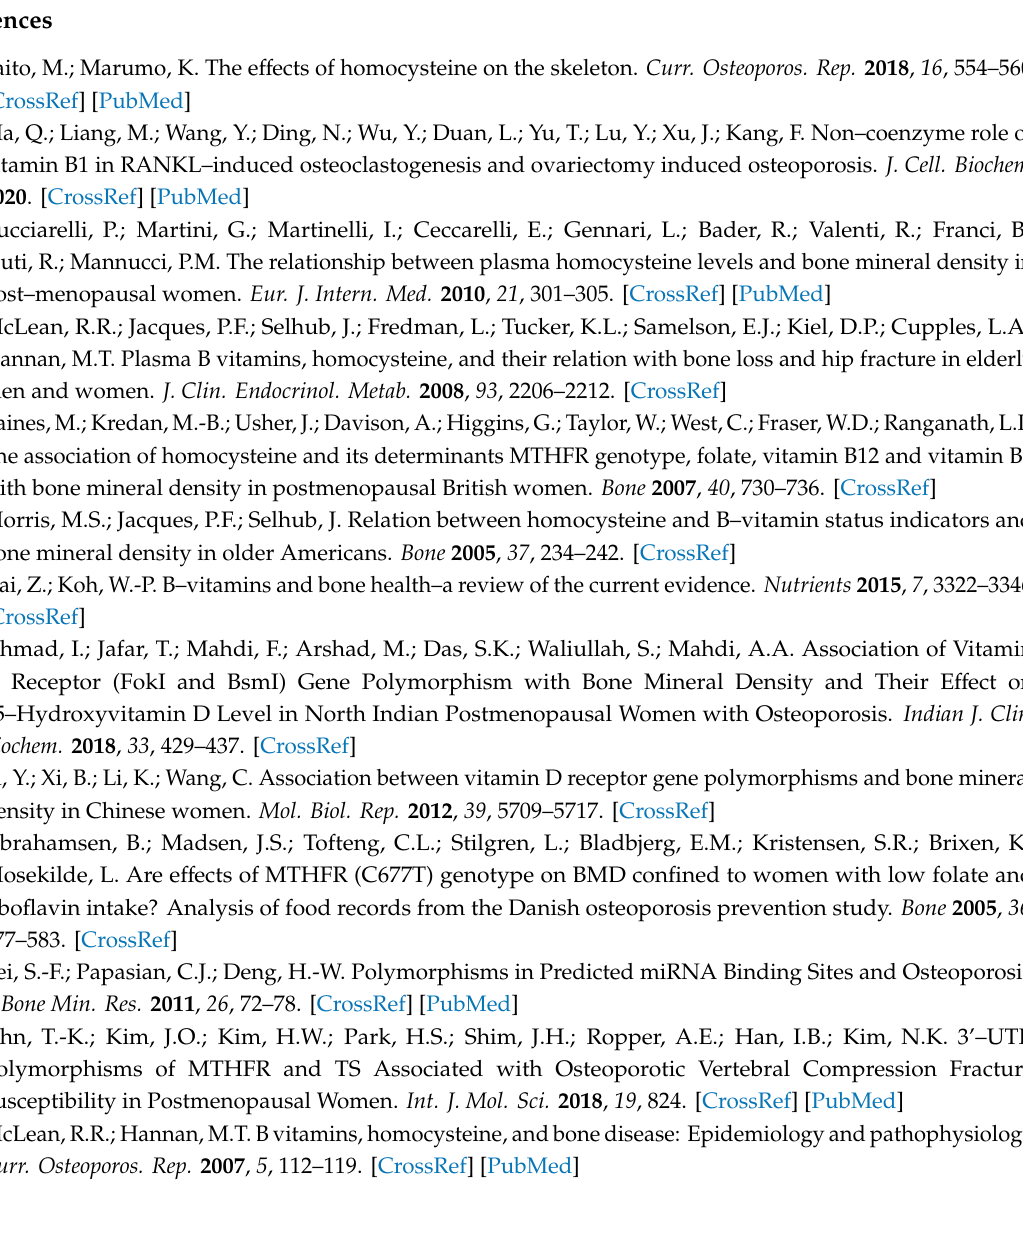
Table S1: Stratified e ff ects in the 3’-UTR polymorphisms of CD320, TCN2, SLC19A1, and SLC19A2 genes on osteoporosis risk; Table S2: Stratified e ff ects in the 3’-UTR polymorphisms of CD320, TCN2, SLC19A1, and SLC19A2 genes on incidence of